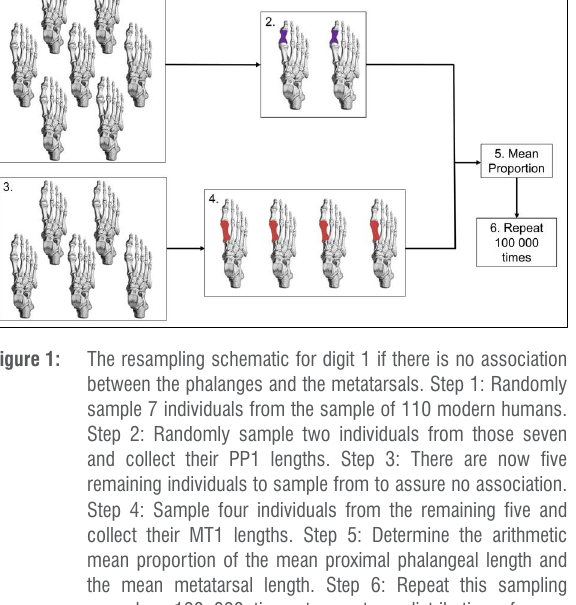
The resampling schematic diagram for digit 2 if there is no association between the phalanges and the metatarsals. The same procedure was applied to digits 3–5. Step 1: Randomly sample 7 individuals from the human sample of 110